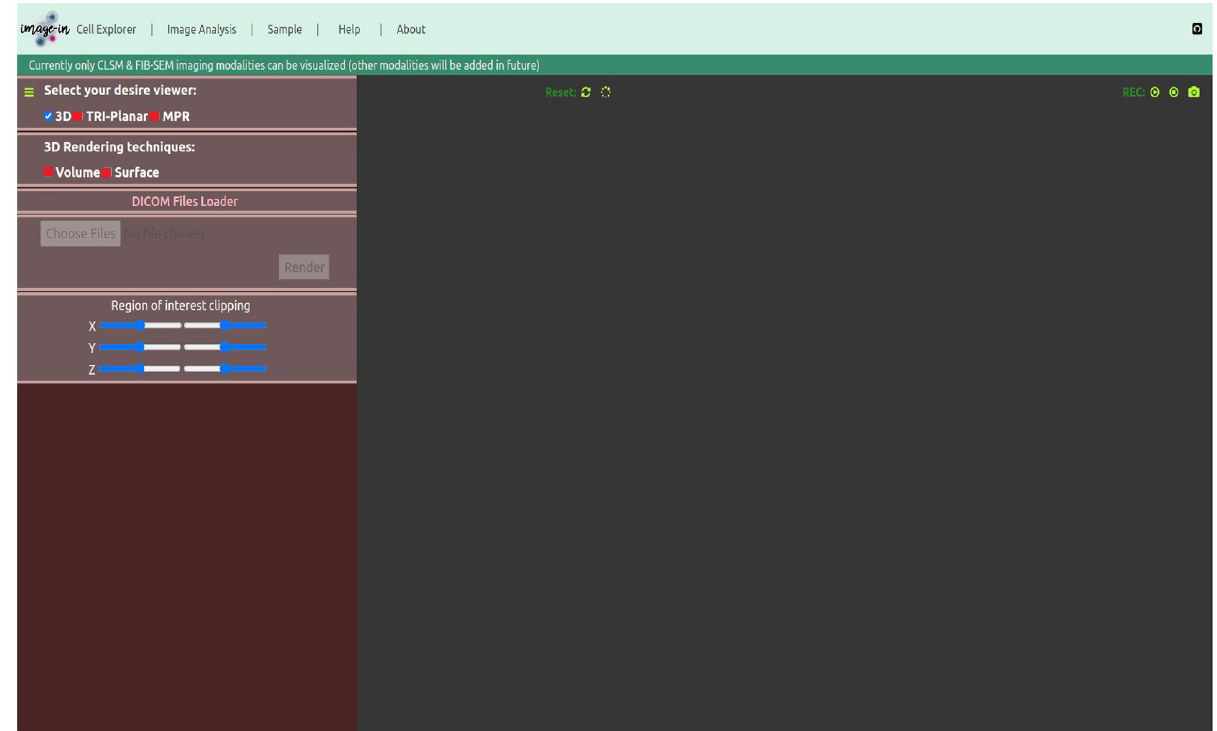
Fig 4. Graphical user interface (GUI) of the IMAGE-IN multidimensional 3D visualizer for visualizing CLSM and FIB-SEM data.